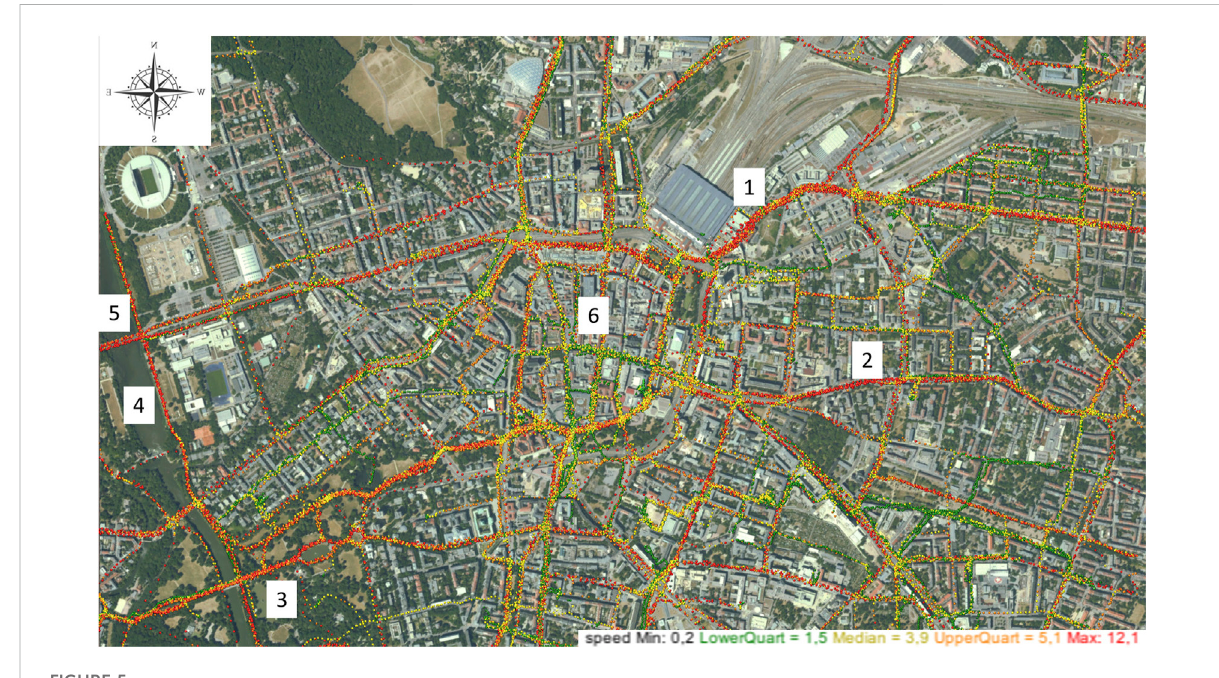
FIGURE 5 Patterns of the speed with which participants moved around the city.